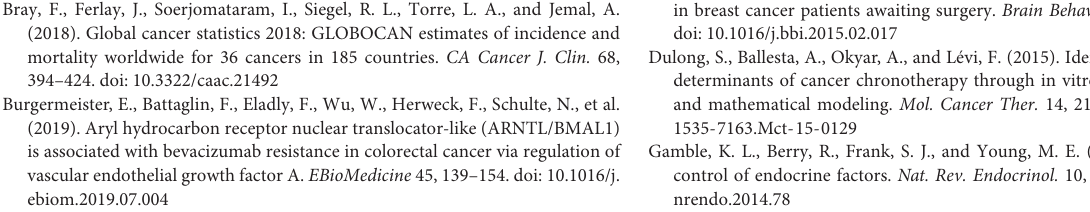
Supplementary Table 1 | The 563 differentially expressed rhythm genes. Supplementary Table 2 | Information on the 377 clinical samples of LIHC.